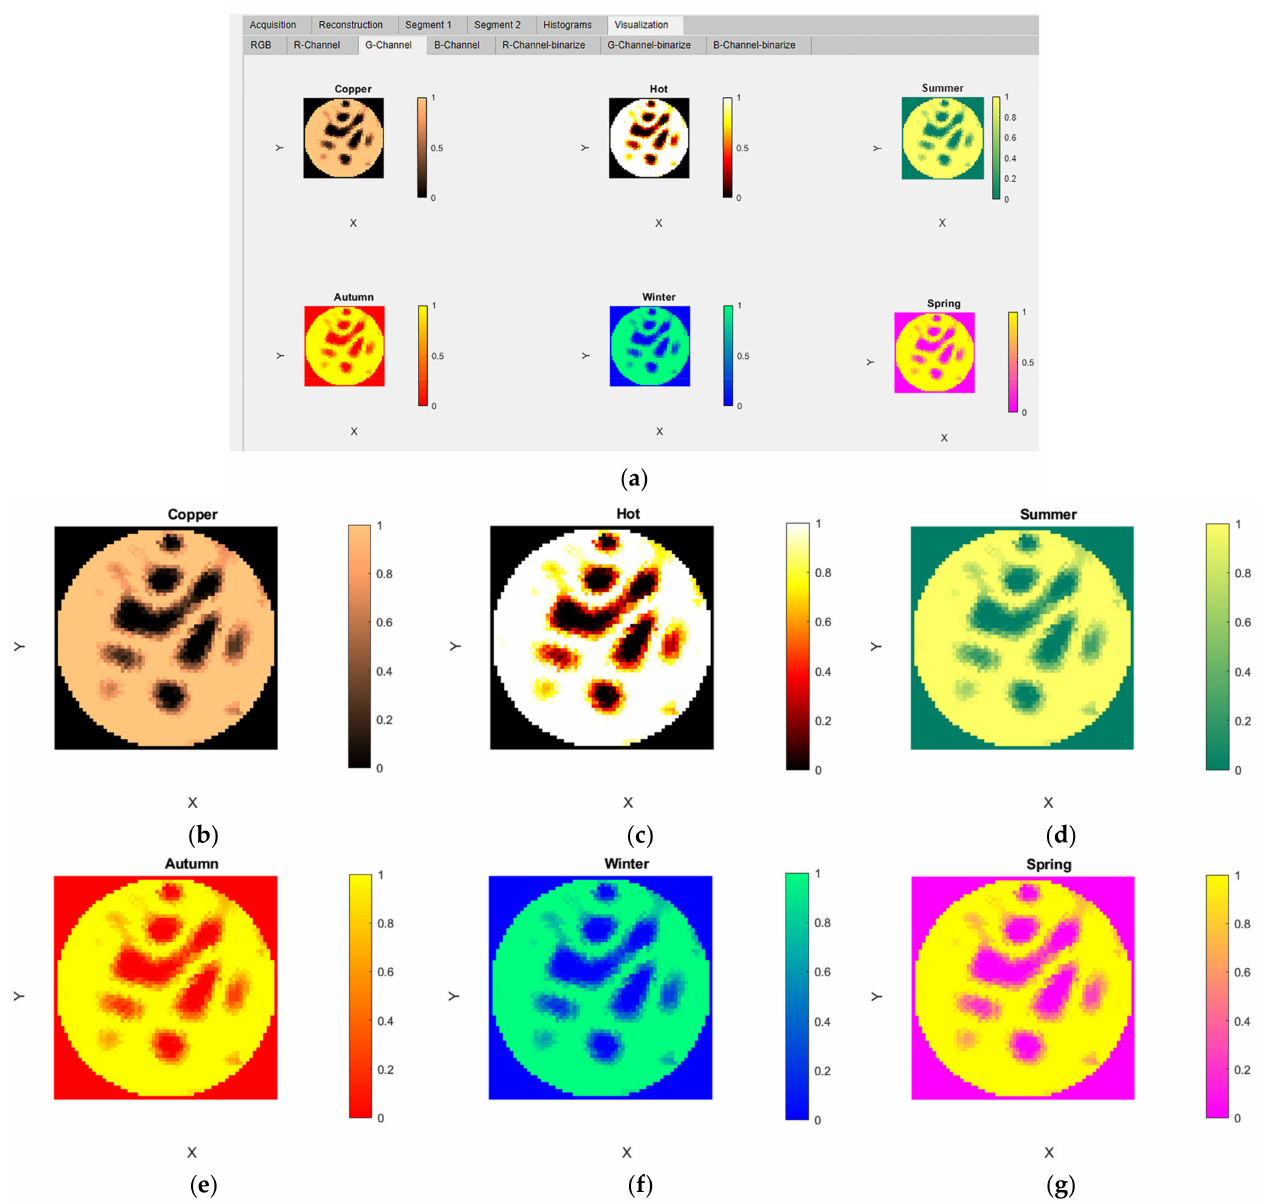
Figure 12. Visualization module: Simultaneous colormap observations subfigure ( a ) G-Channel ob- served with various colormaps, colormaps implemented: ( b ) copper; ( c ) hot; ( d ) summer; ( e ) autumn; ( f ) winter; ( g )